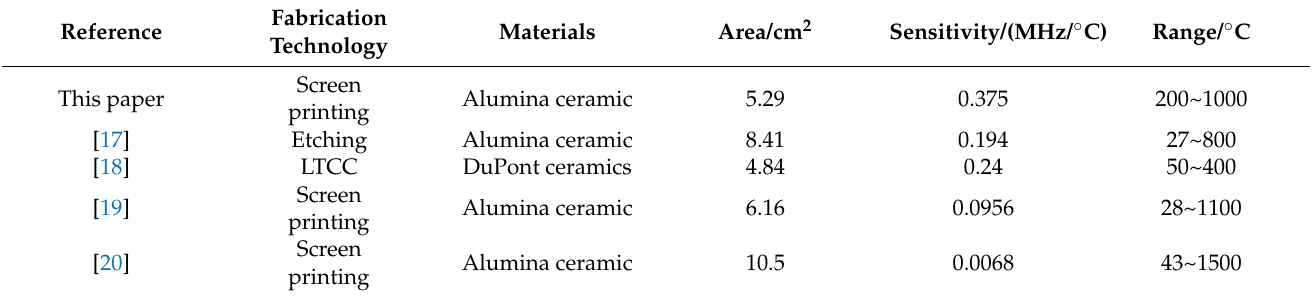
Table 2. Parameter comparison of temperature